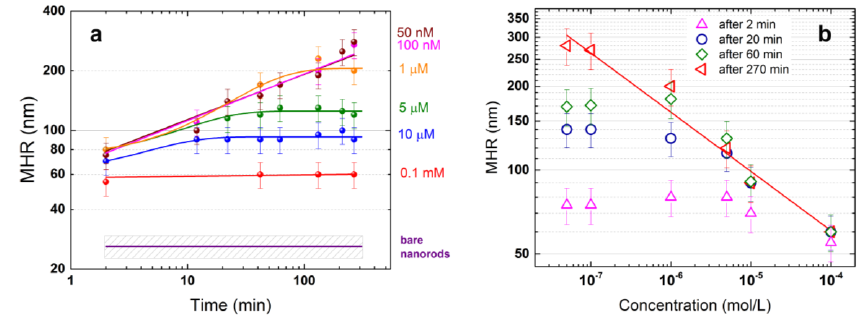
Figure 3. ( a ) Mean hydrodynamic radius (MHR) of BIO-NRCs as a function of time at BSA concentrations of 0.1 mM (red dots), 10 µ M (blue dots), 5 µ M (green dots), 1 µ M (orange dots), 100 nM (pink dots) and 50 nM (brown dots). The solid colored lines are fits of the experimental data using a model r ( t ) = r 0 + A 1 − e − t / t 0 . Best fit parameters are: r 0 = 70 ± 20 nm, A = 140 ± 20 nm, t 0 = 45 ± 20 min (orange line, 1 µ M); r 0 = 72 ± 7 nm, A = 53 ± 7 nm, t 0 = 11 ± 3 min (green line, 5 µ M); r 0 = 60 ± 10 nm, A = 35 ± 10 nm, t 0 = 5 ± 3 min (blue line, 10 µ M). The purple line represents the MHR measured on the CTAB-coated pristine NRs. Data at 100 nM and 50 nM are fitted with a power law r ( t ) ∼ t b with b = 0.23 ± 0.01 for both concentrations (pink and brown lines). ( b ) MHR as a function of protein concentration after 2 min (pink triangles), 20 min (blue circles), 60 min (green diamonds) and 270 min (red triangles) from the mixing. (red line) Power law fit of the data. Best fit exponent − 0.21 ±